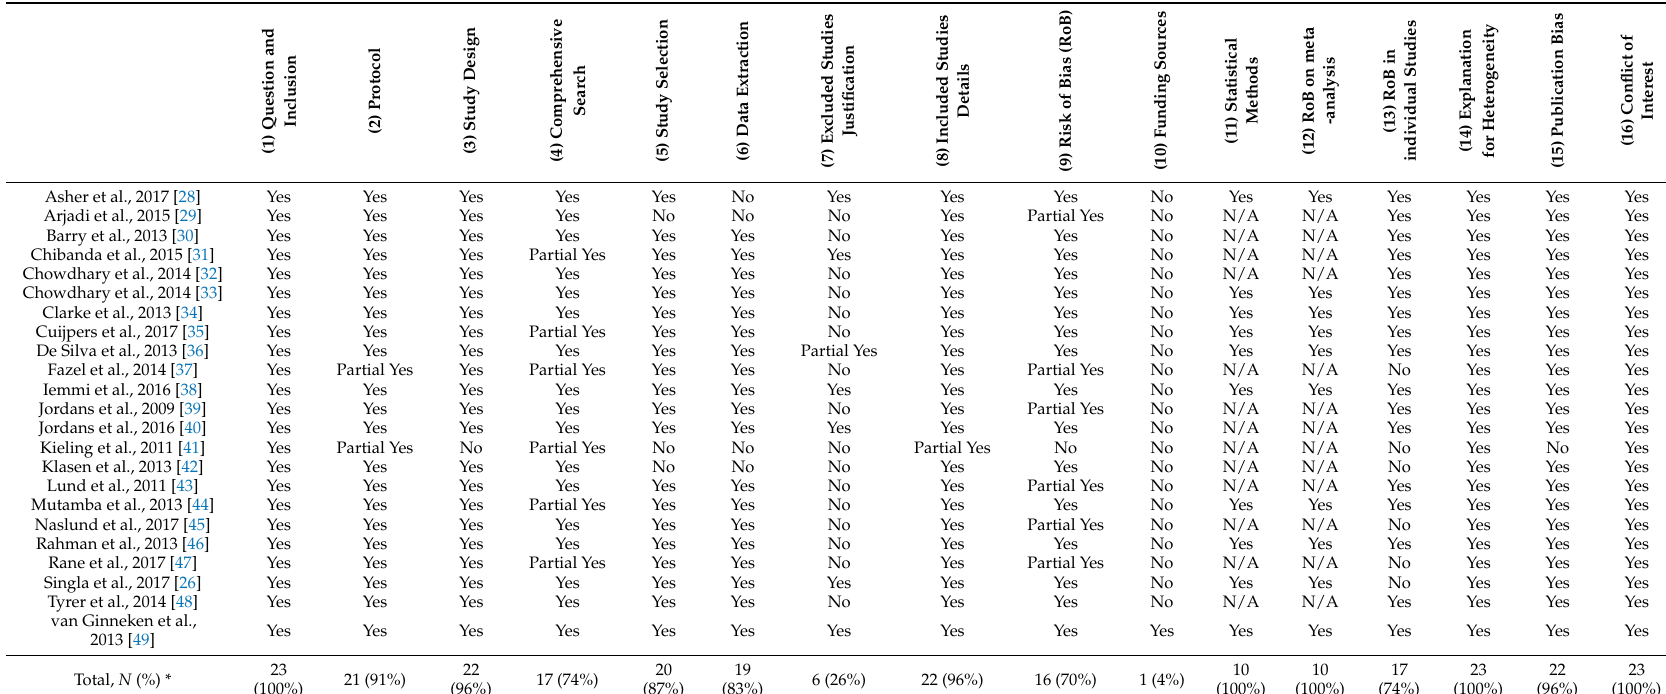
Abbreviations: RoB, Risk of Bias. * Percent is based on number of eligible reviews per